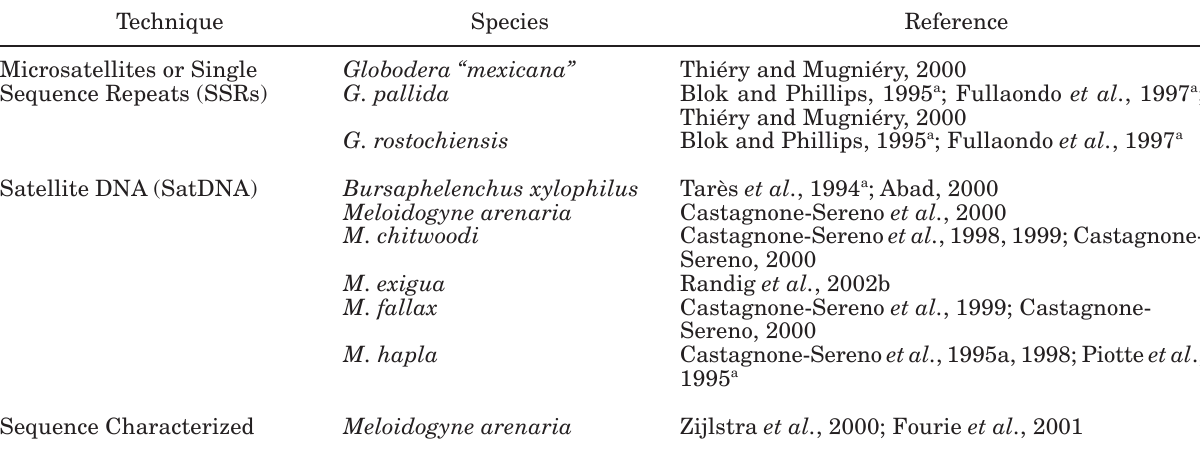
Table 10. Plant-parasitic nematodes species characterized by other DNA-based techniques.